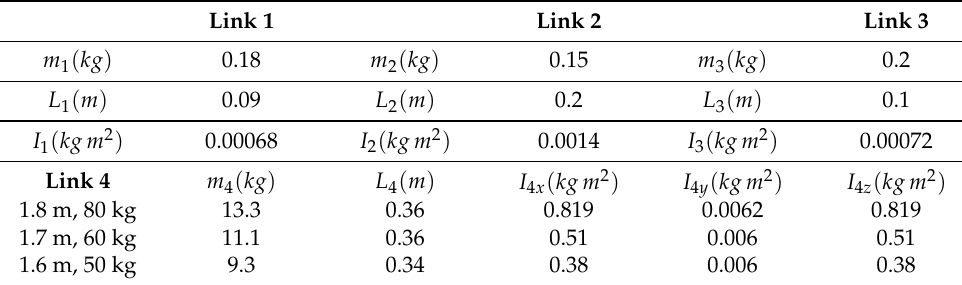
Table 2. Selected parameters for the